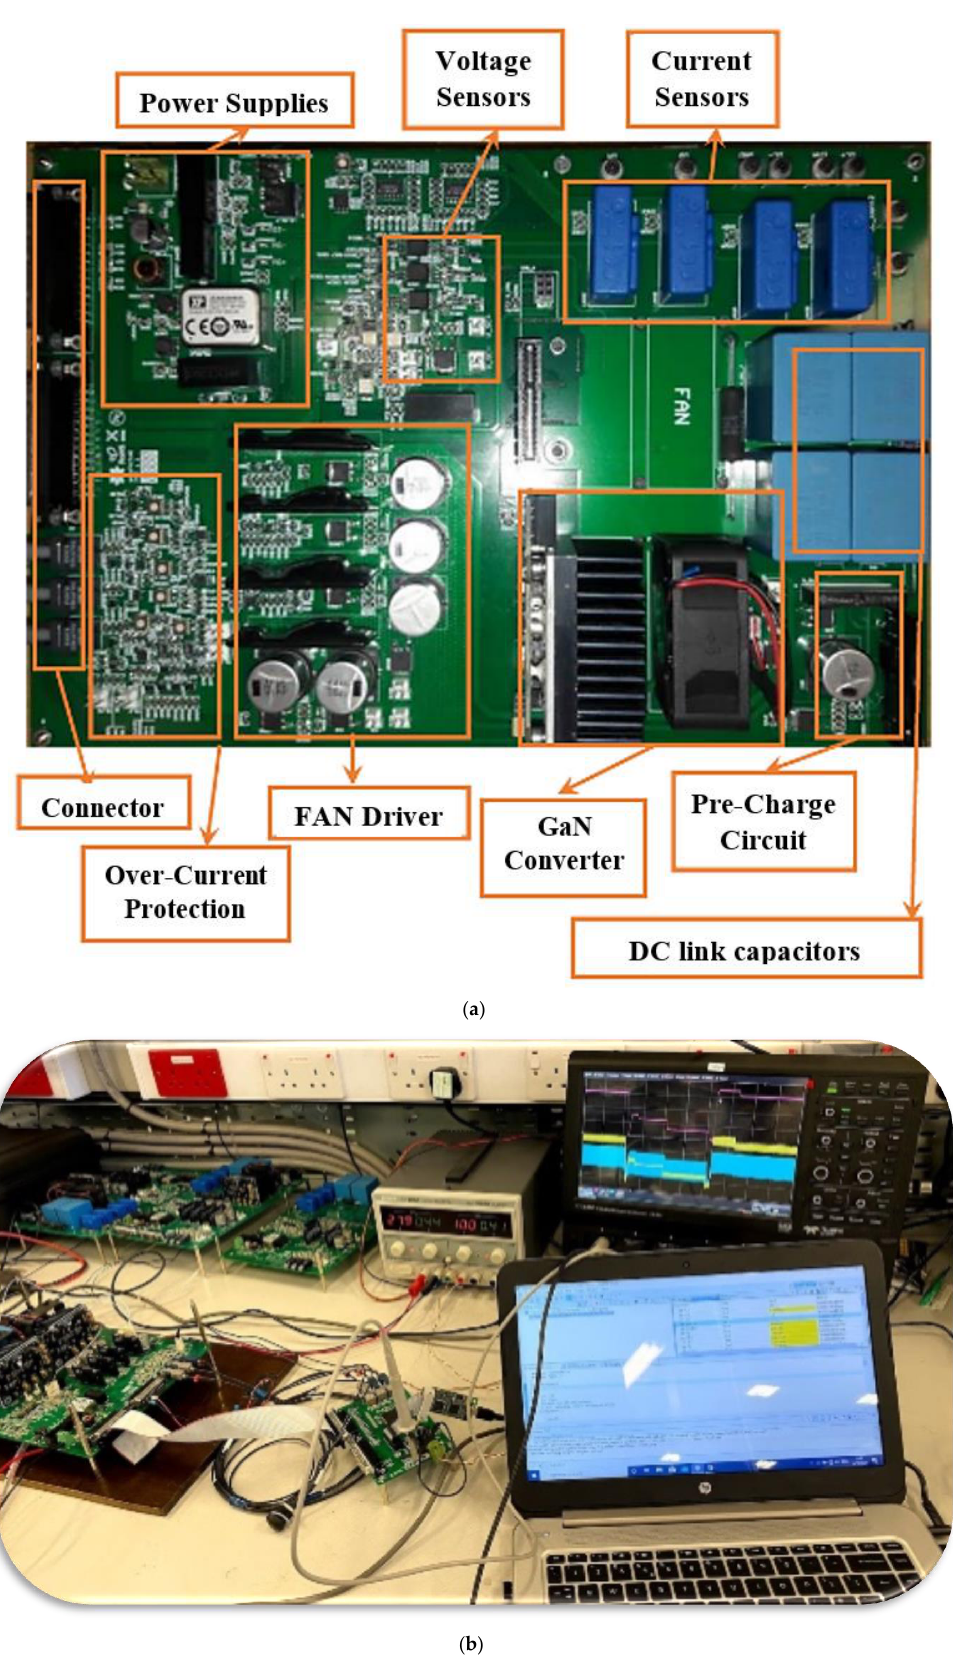
Figure 13. Experimental setup for performance evaluation of the proposed SMC; ( a ) Designed converter. ( b ) Experimental rig.